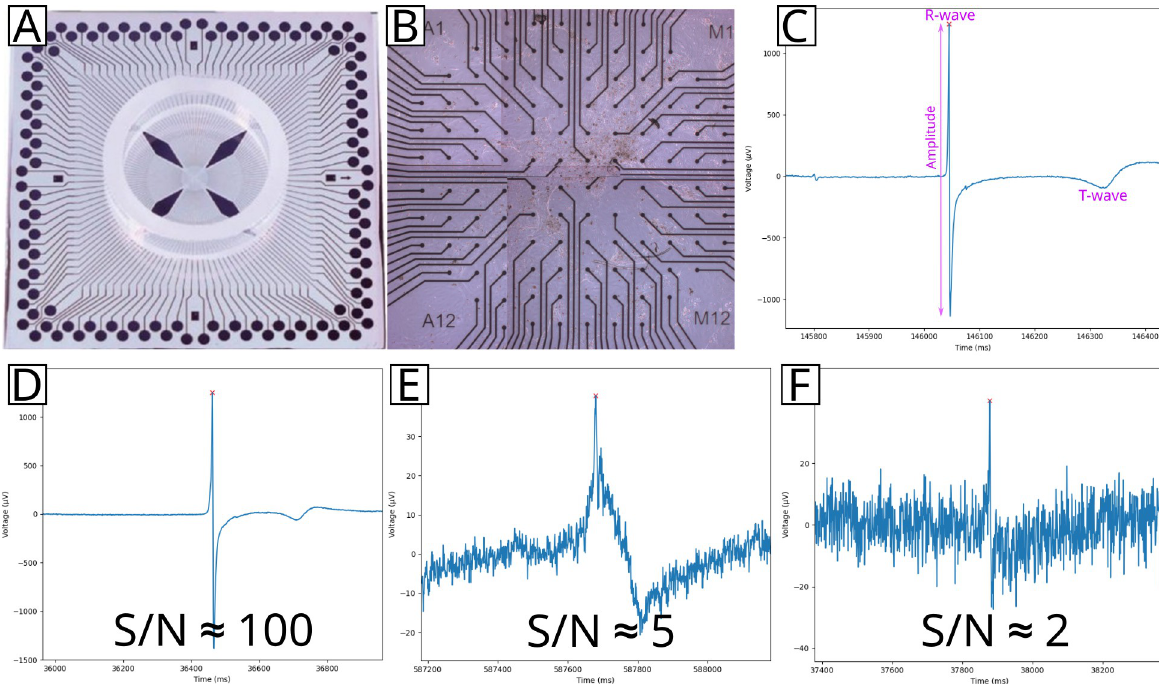
Fig 6. Beat detection results for an MEA-plated cardiomyocyte culture. An individual 120 electrode MEA (A) was plated with cardiomyocytes (B). Field potentials were recorded (C) and analyzed to determine the R-wave-like peak, beat amplitude, T-wave endpoint, and other features. These field potentials showed varying levels of noise, ranging from clean (D) to moderately (E) or significantly (F) noisy, as indicated by the decreasing signal-to-noise (S/N) ratios. Beat detection was performed for all field potentials across all MEAs.